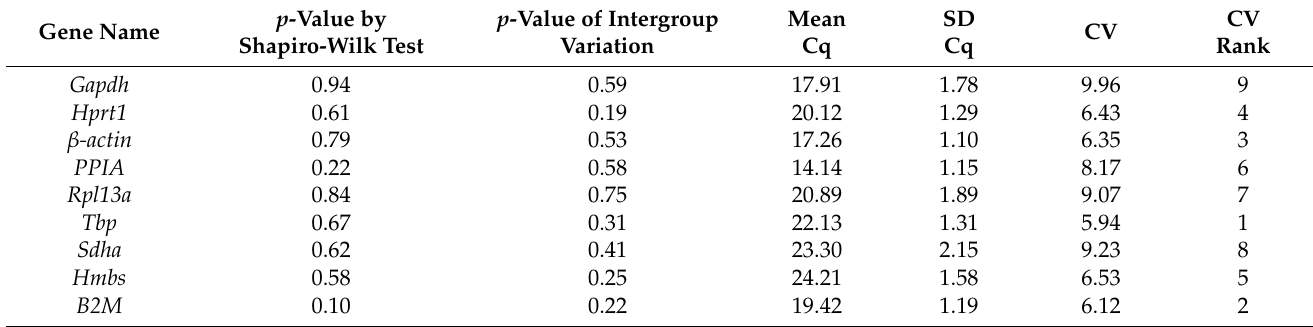
Table 9. Expression features in hypothalamus tissues at the developmental stage of PND 12w under different photoperiod conditions analyzed by SPSS.